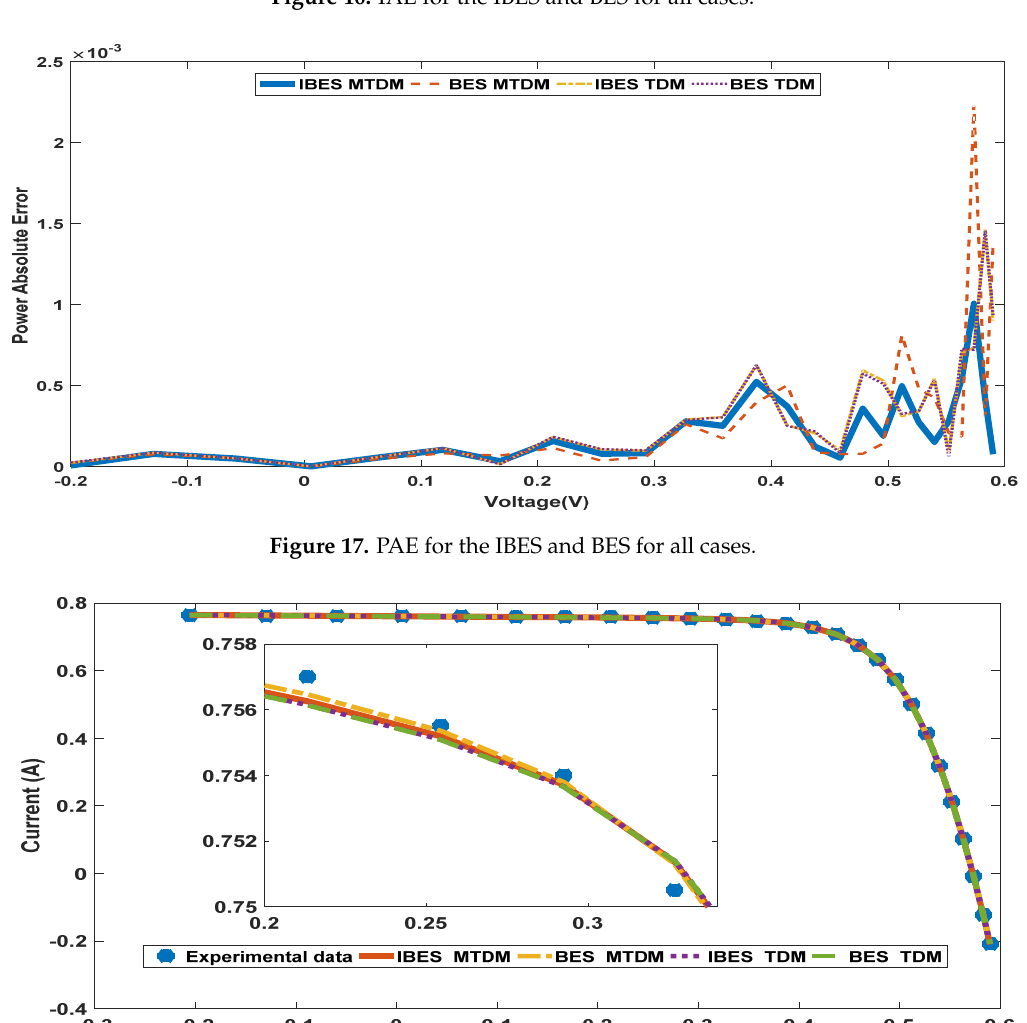
Figure 16. IAE for the IBES and BES for all cases.